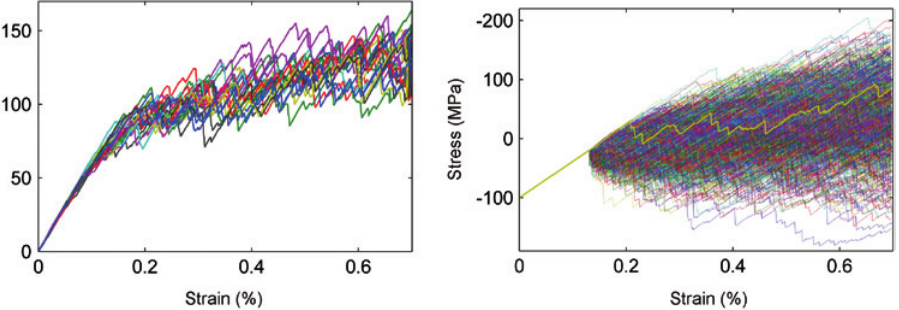
Figure 6: Comparison of stochastic simulation results (right) with the stress-strain curves of 22 DDD simulations (left, see also Figure 2).